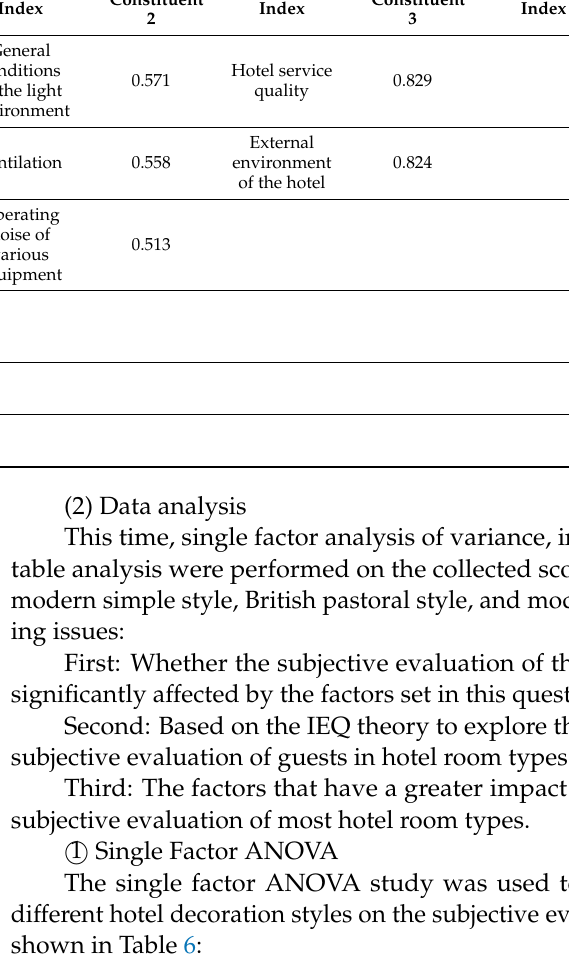
Table 6. Results of single factor ANOVA on the rating of hotel 3 decoration style by various influenc- ing